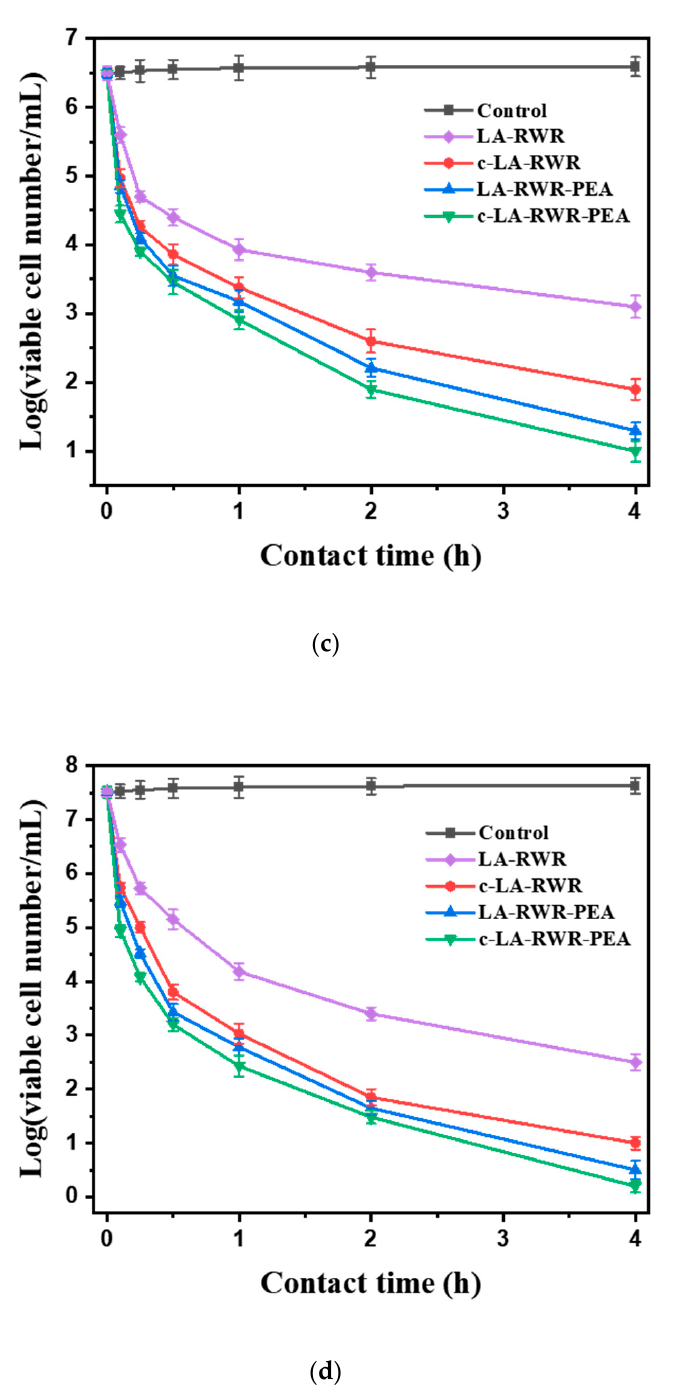
Figure 3. Time-kill curves of LA-RWR, c-LA-RWR nanoparticles, LA-RWR-PEA, and c-LA-RWR-PEA nanoparticles against ( a ) E. coli , ( b ) S. aureus , ( c ) C. albicans , and ( d ) MRSA.